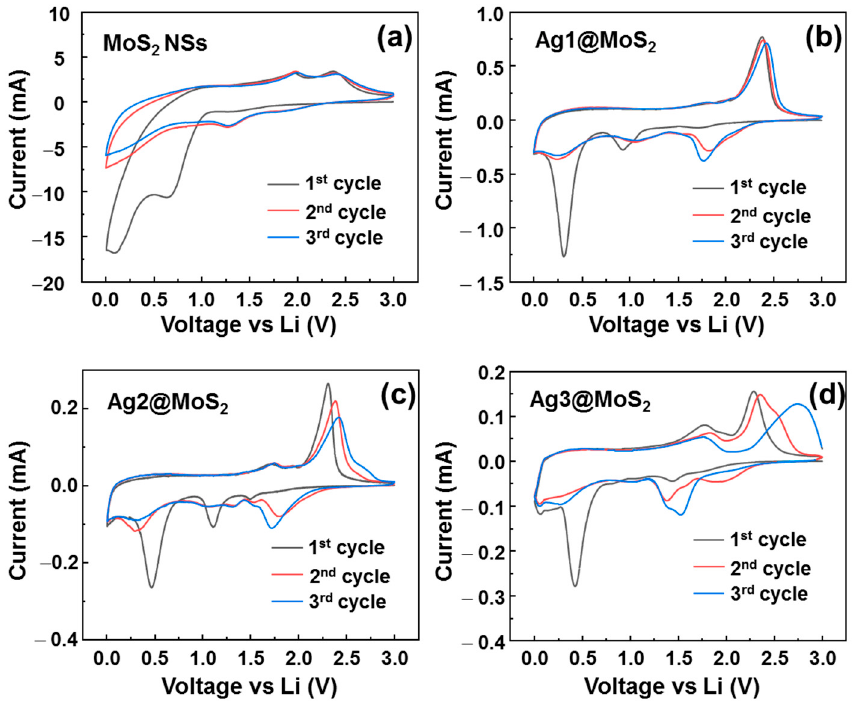
Figure 4. Cyclic voltammetry (CV) profiles of ( a ) MoS 2 NSs, ( b ) Ag1@MoS 2 , ( c ) Ag2@MoS 2 and ( d ) Ag3@MoS 2 anodes, over the initial three cycles.